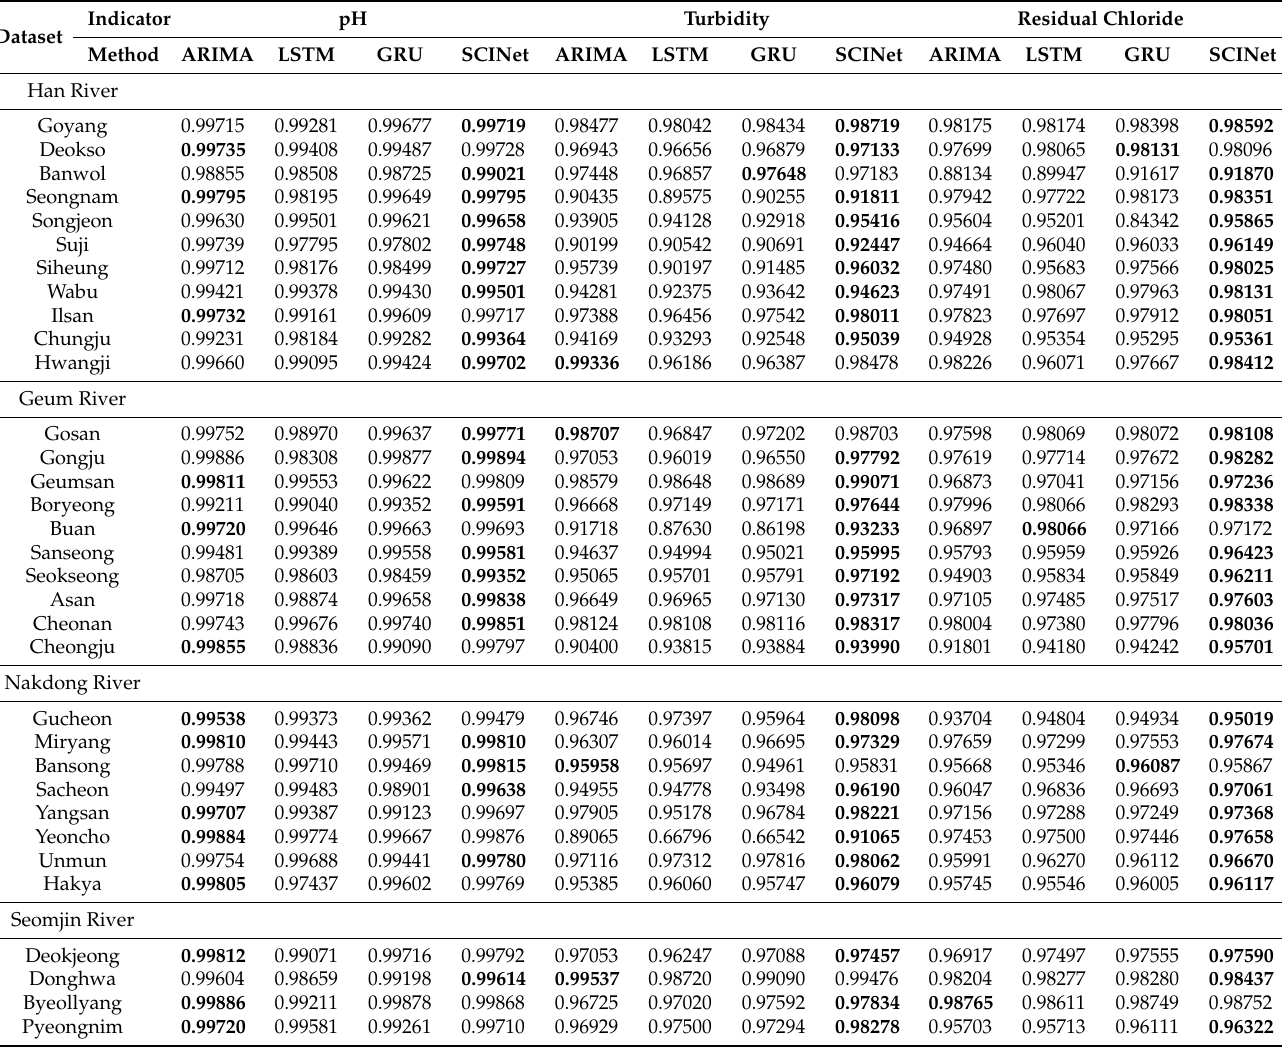
Table 6. Overall accuracy evaluation of four model